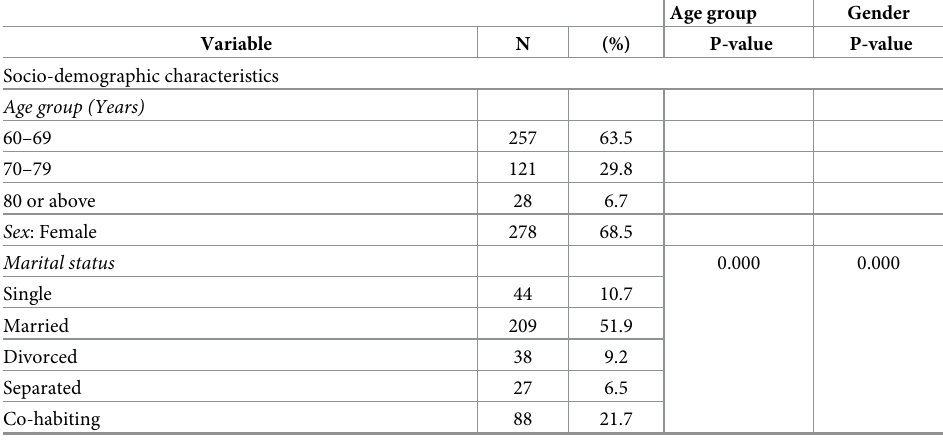
Table 1. Socio-demographic and clinical characteristics of the study